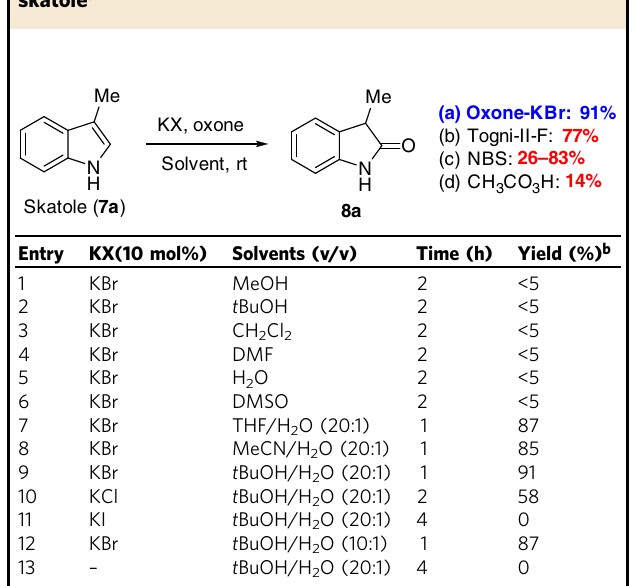
Table 3 Selected conditions for oxone-KBr oxidation of skatole